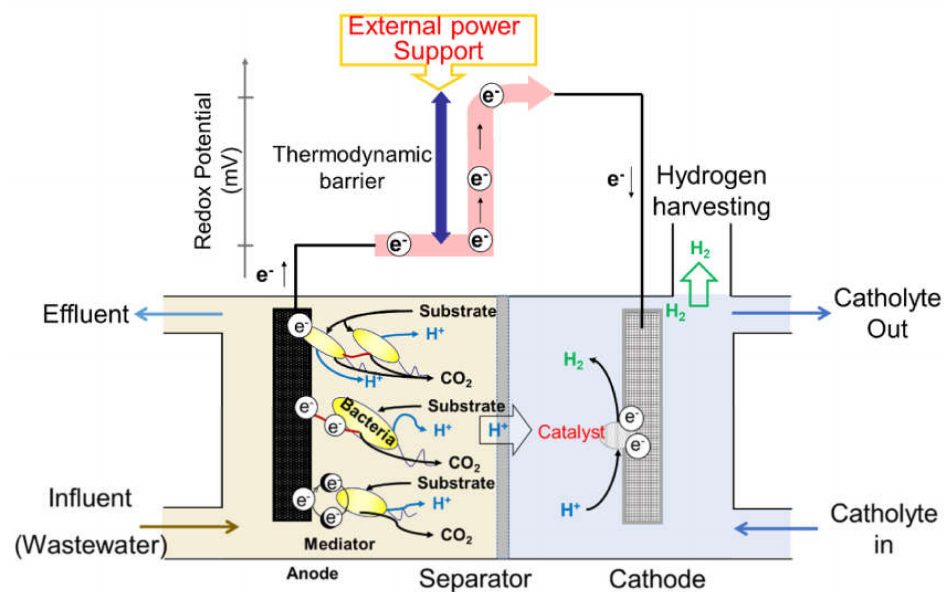
Figure 1. Schematic illustration of the working principle of microbial electrolysis